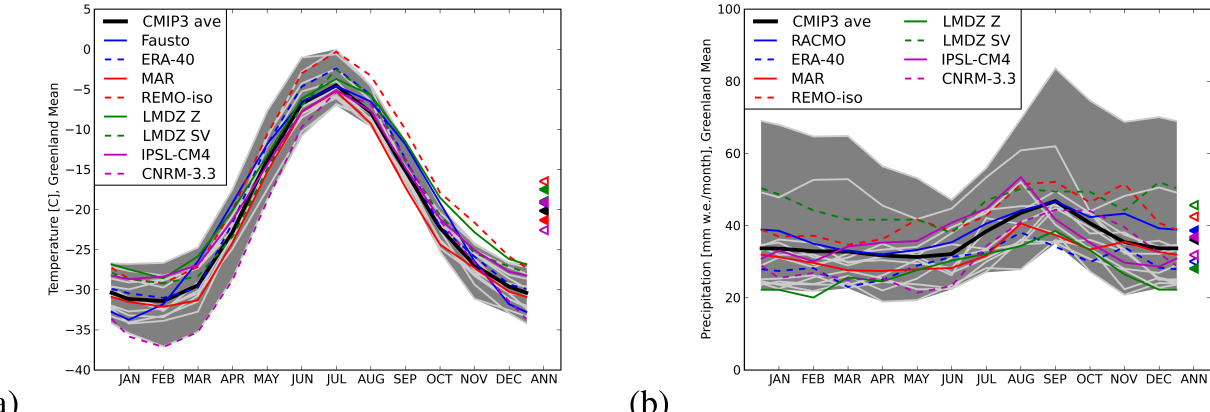
Fig. 2. Greenland (land points) mean seasonal cycle of near surface air temperature (in ◦ C, left panel) and precipitation (in millimetres of water equivalent per month, right panel) for the 8 atmospheric forcing fields used in this study (coloured lines). For FE09, temperature is representative for the 1996–2006 period (Fausto et al., 2009) and precipitation for the 1958–2009 period (Ettema et al., 2009). For the other forcing fields, climatological means are evaluated on the 1980–1999 period. Annual mean values are represented by triangles on the right. The grey, shaded area is the spread of 12 CMIP-3 models. Light grey and black lines, respectively, represent individual models and their means.